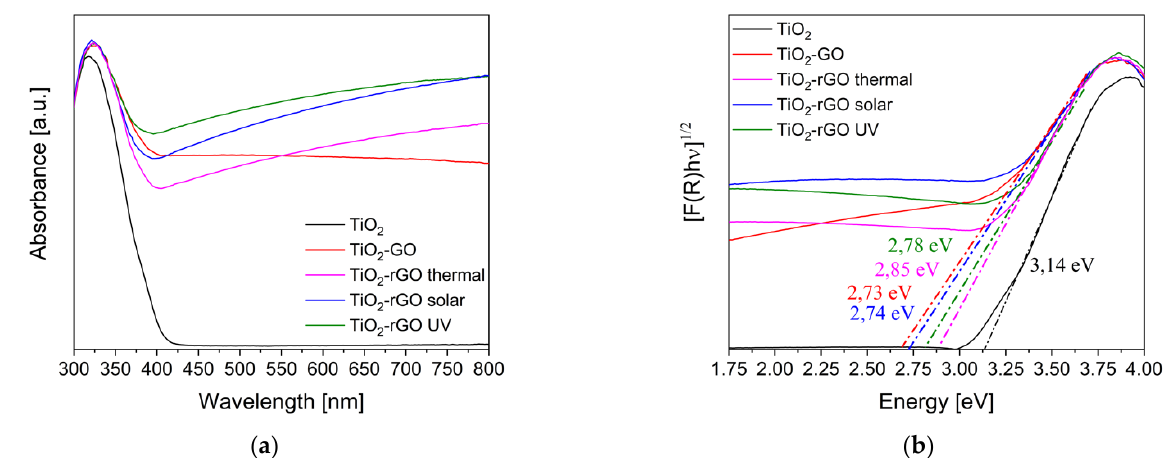
Figure 1. ( a ) UV-DRS spectra of the photocatalysts; ( b ) Kubelka-Munk functions for the optical band gap estimation. In comparison with the bare TiO 2 , the samples containing GO and rGO show a marked absorption on all visible range, stronger for the thermal treated and UV or solar reduced samples. Furthermore, the absorption band onset of the composites exhibits a slight